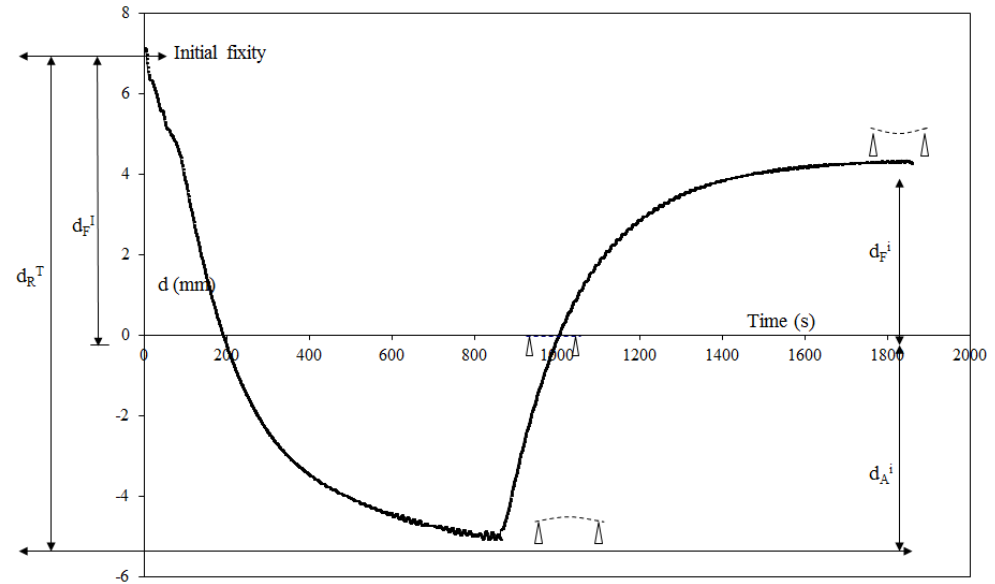
Figure 5. Definition of the geometrical